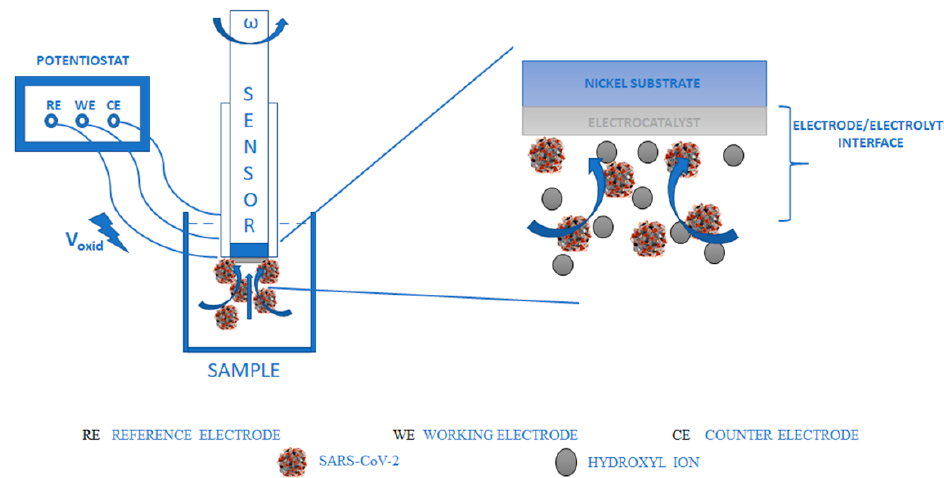
Figure 2. Schematic of the experimental setup containing 3 electrodes that are connected to a potentiostat and immersed in a solution containing SARS-CoV-2. A zoomed in visualization of the electrode/electrolyte interface where the SARS-CoV-2 interacts with electrocatalyst to produce an electric current response is shown on the right.